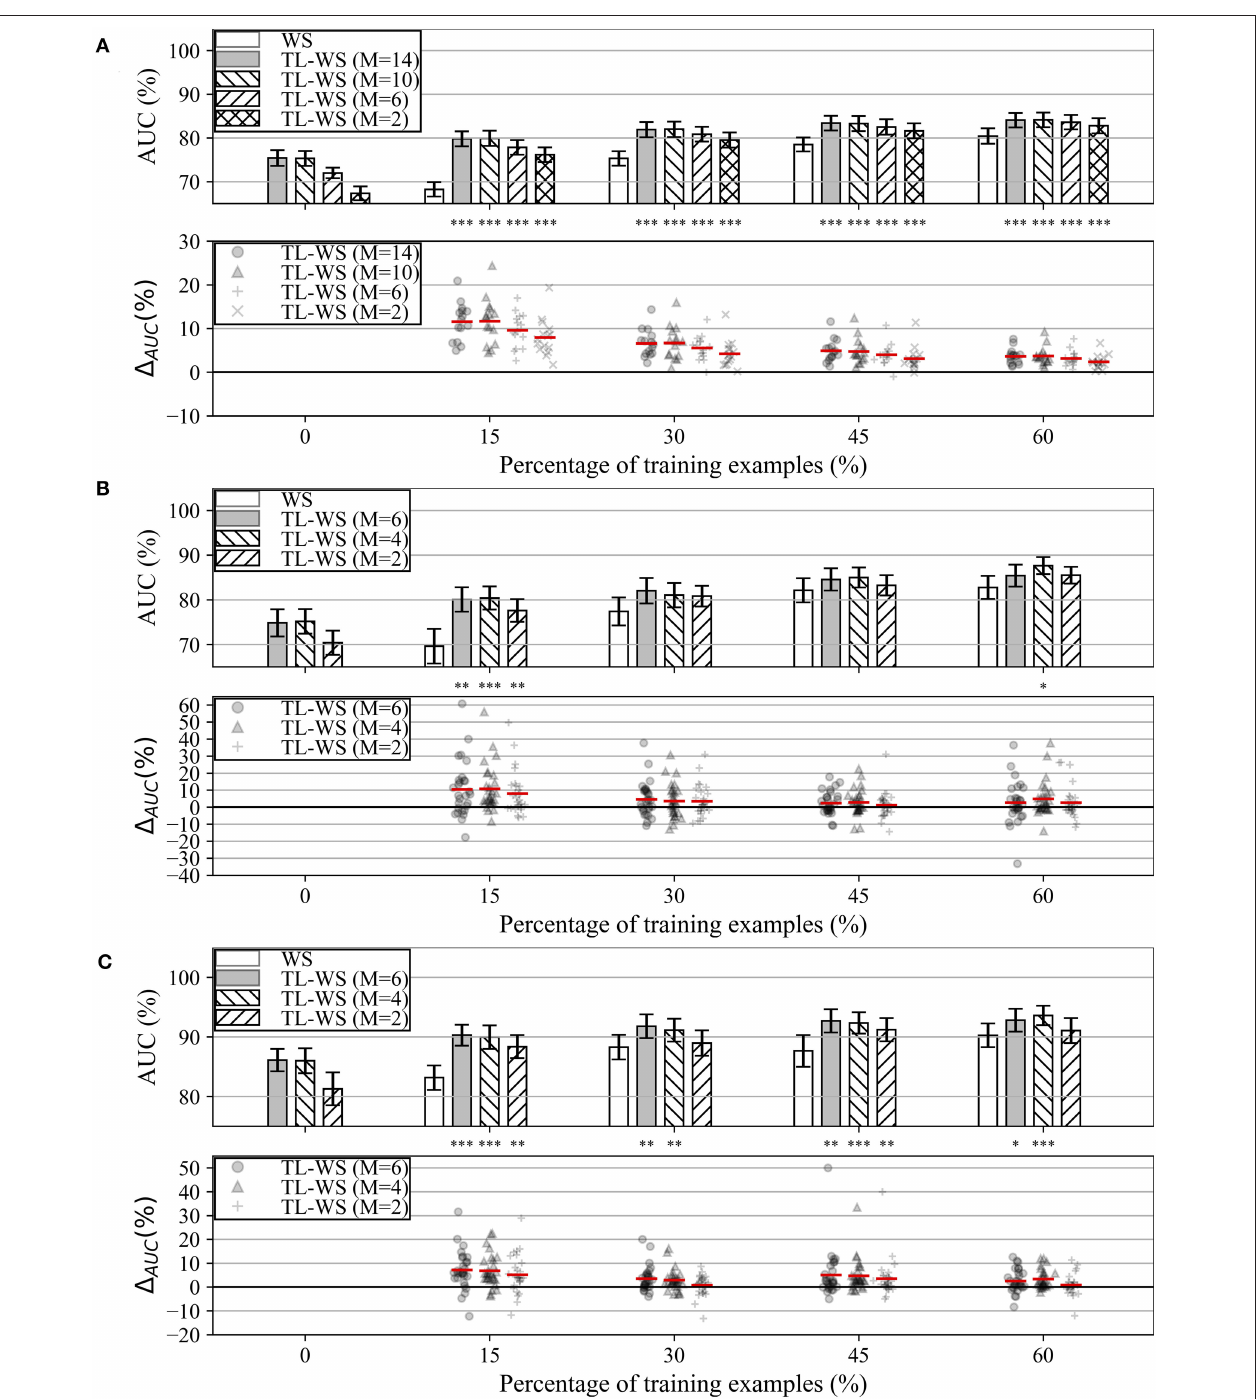
FIGURE 3 | AUC obtained with MS-EEGNet trained with the WS and TL-WS strategies for datasets 1–3 (panels A–C , respectively). Top plot in each panel: The AUC obtained in WS (white bars) is reported as a function of the percentage of training examples (reported on the x-axis), while the AUC obtained in TL-WS is reported also as a function of the number of participants ( M ) used to optimize the LOSO-M models (gray and hatched bars). The height of each bar represents the mean value of the performance metric across the participants, while the error bar (black lines) represents the standard error of the mean. Bottom plot in each panel: The AUC difference between the TL-WS and WS strategies (i.e., 1 AUC = AUC TL − WS − AUC WS ) using the same percentage of training examples is reported using markers, and a red line denotes the mean value. For each percentage, a Wilcoxon signed-rank test was performed (see section Statistics-iii) to compare TL-WS vs. WS strategy, and the statistical significance is reported (* p < 0.05, ** p < 0.01, *** p < 0.001, corrected for multiple tests) on top of each plot.